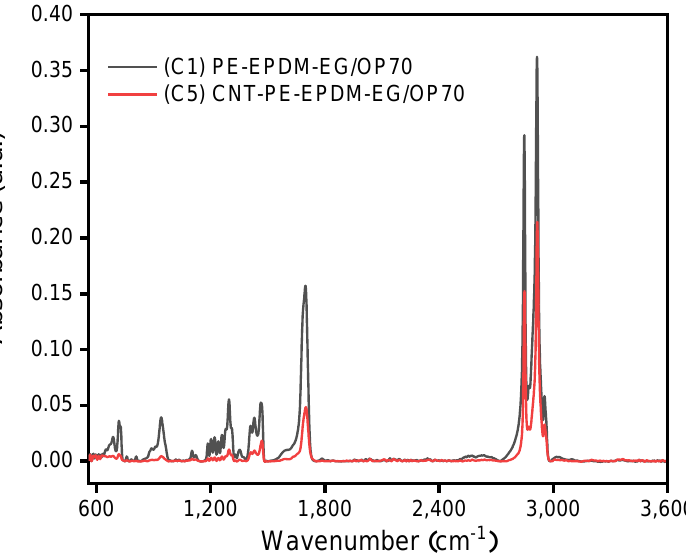
Figure 5. ATR FT-IR spectra of PE-EPDM/EG-based (C1) and CNT/PE-EPDM/EG-based (C5) phase change composites